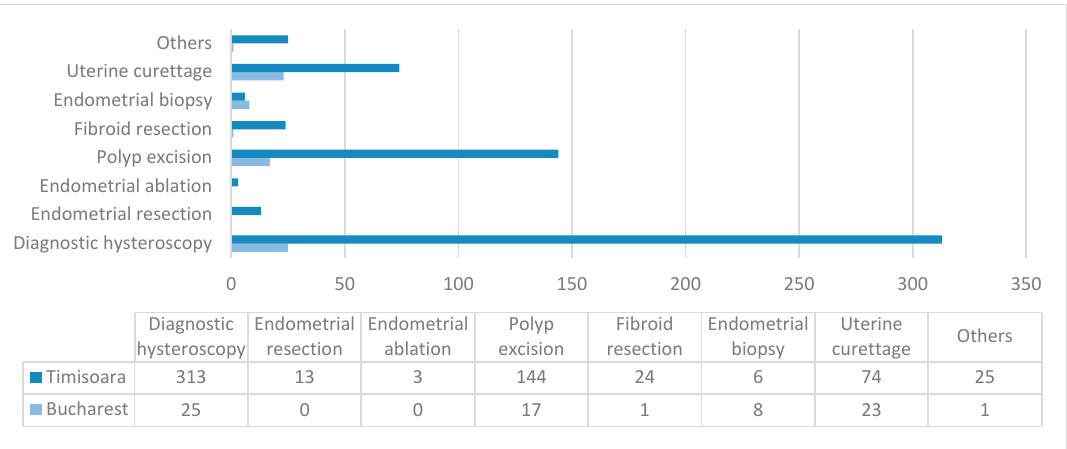
Figure 2. Main hysteroscopic procedures in the two centers. Data are presented as N .